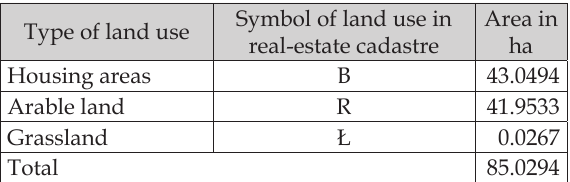
Table 2. Types of land use on built-up housing lots in Rokietnica commune,